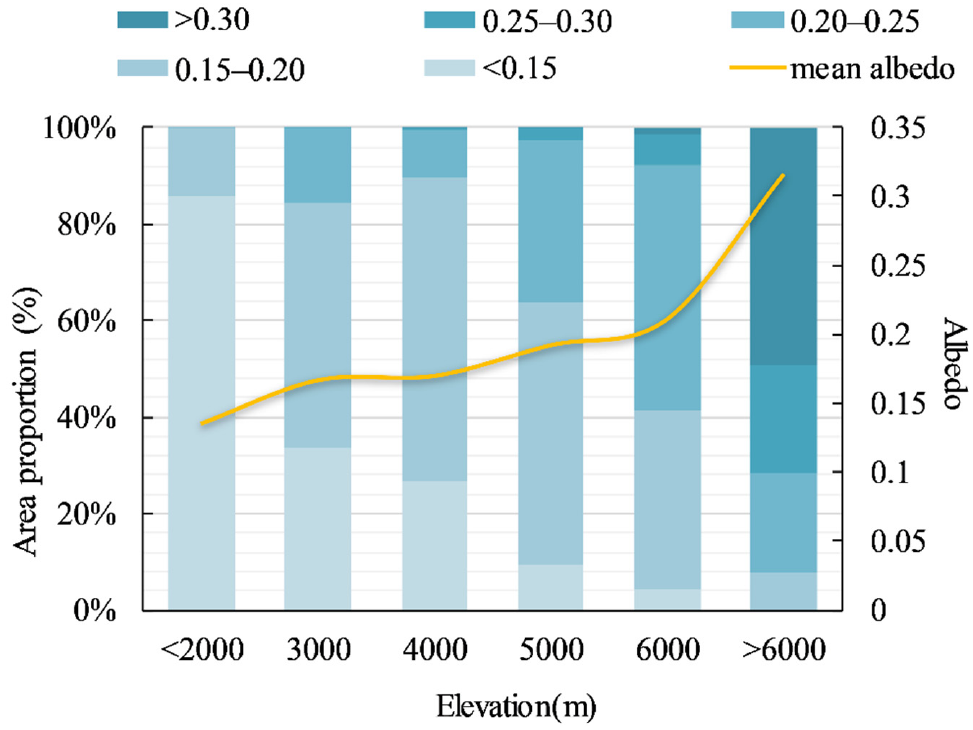
Figure 3. Vertical characteristics of average annual albedo during 2000–2016 in the growing season: the yellow line shows the mean annual albedo at different elevations and the numbers next to the various shades of blue in the legend refer to albedo ranges.